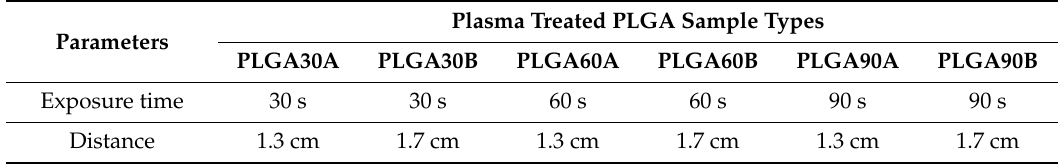
Table 1. Annotations of di ff erent plasma treated PLGA sample